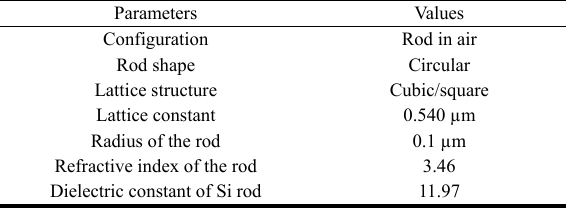
Table 1 Design parameters of the proposed biosensor.